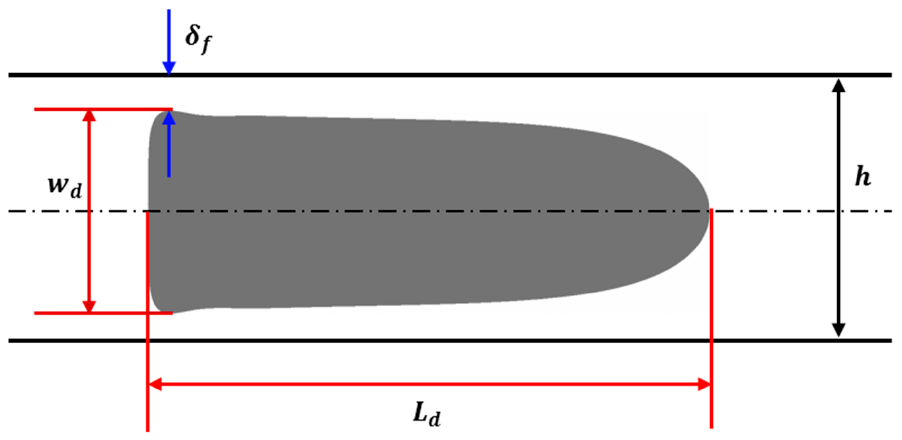
Figure 9. Measurement of the droplet length, width and minimum film thickness.